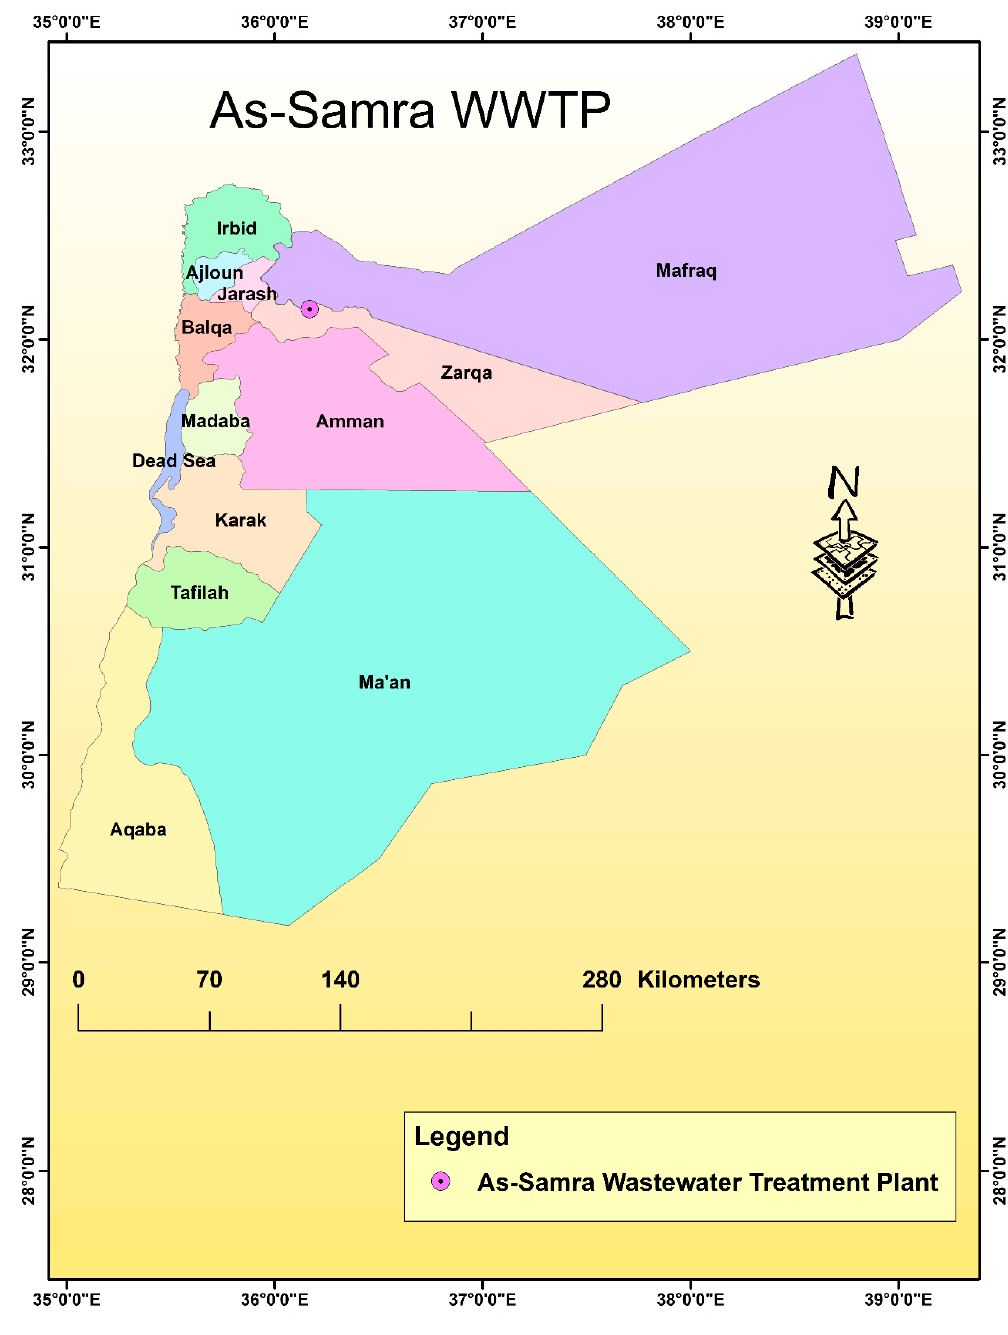
Figure 1. Location of As-Samra Wastewater Treatment Plant (WWTP).